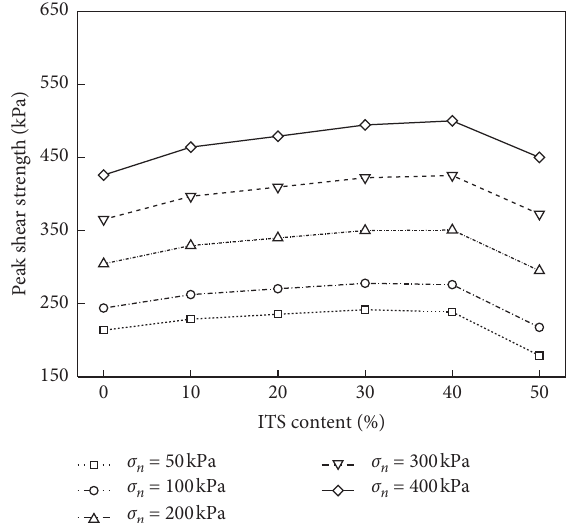
Figure 8: Variations of the peak shear strength with ITS content.